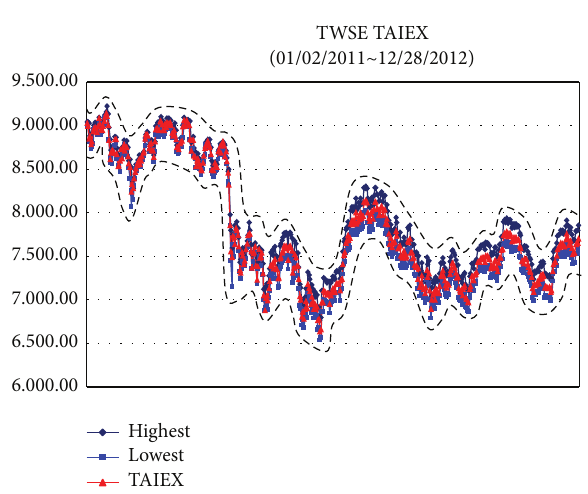
Figure 5: TAIEX [26] from 01/02/2009 to 12/28/2012